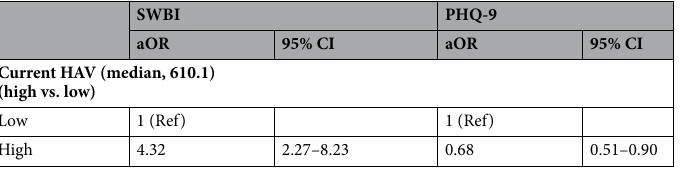
Table3. Associations of current health asset with subjective well-being and depression, adjusted for age, sex, income, and comorbidity ( n = 1000), multiple stepwise model*. HAV health asset value, aOR adjusted odds ratios, CI confidence interval, Ref reference, SWBI Subjective Well-Being Index, PHQ-9 Patient Health Questionnaire-9. *Multiple stepwise logistic regression models selected significant variables with p-value of stay = 0.05, leave = 0.05, adjusted with age (≤ 50 vs. > 50), sex (male vs. female), household monthly income (< 3000$ vs. 3000$ ≤), and comorbidity (no vs. yes).